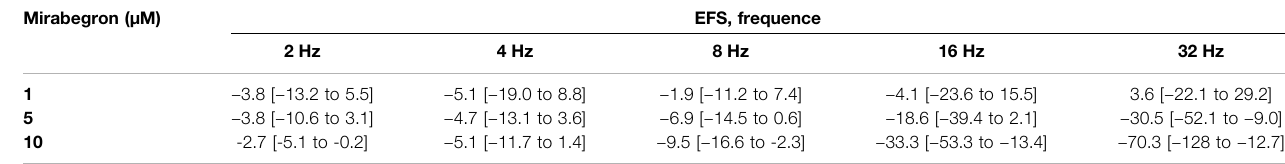
TABLE1| Meandifferences(MD)forEFS-inducedcontractionsofhumanprostatetissuesafterapplicationofmirabegron(1,5,10 µM)orDMSOforcontrols,shownforeach appliedfrequenceandwith95%con fi denceintervals(CI)(insquarebrackets,lowtohigh)(%ofKCl-inducedcontractions).Differencesincontractionatgivenfrequencies were calculated for each single experiment (i. e., between mirabegron and control group, for corresponding, paired samples from the same prostate in each single experiment), and are expressed as MD with 95% CI. Mirabegron (µM) EFS,